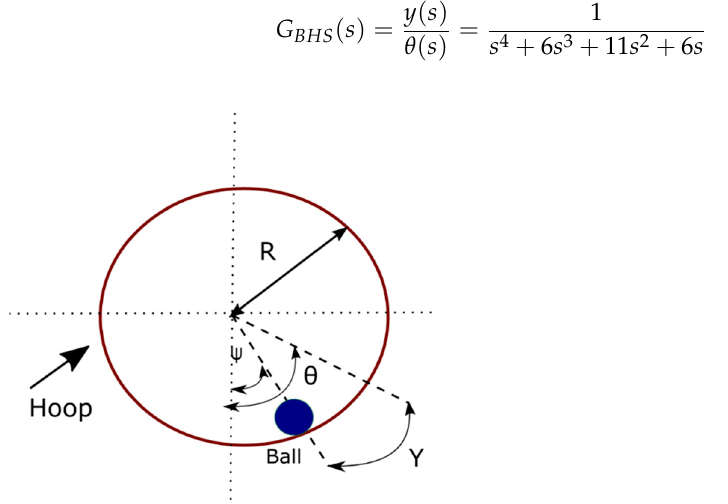
Figure 15. Schema of the ball and hoop system [14].